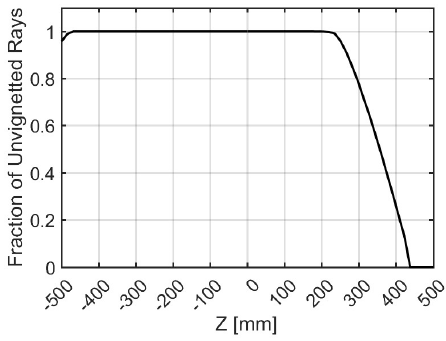
Figure 3. Vignetting diagram of the lens module.